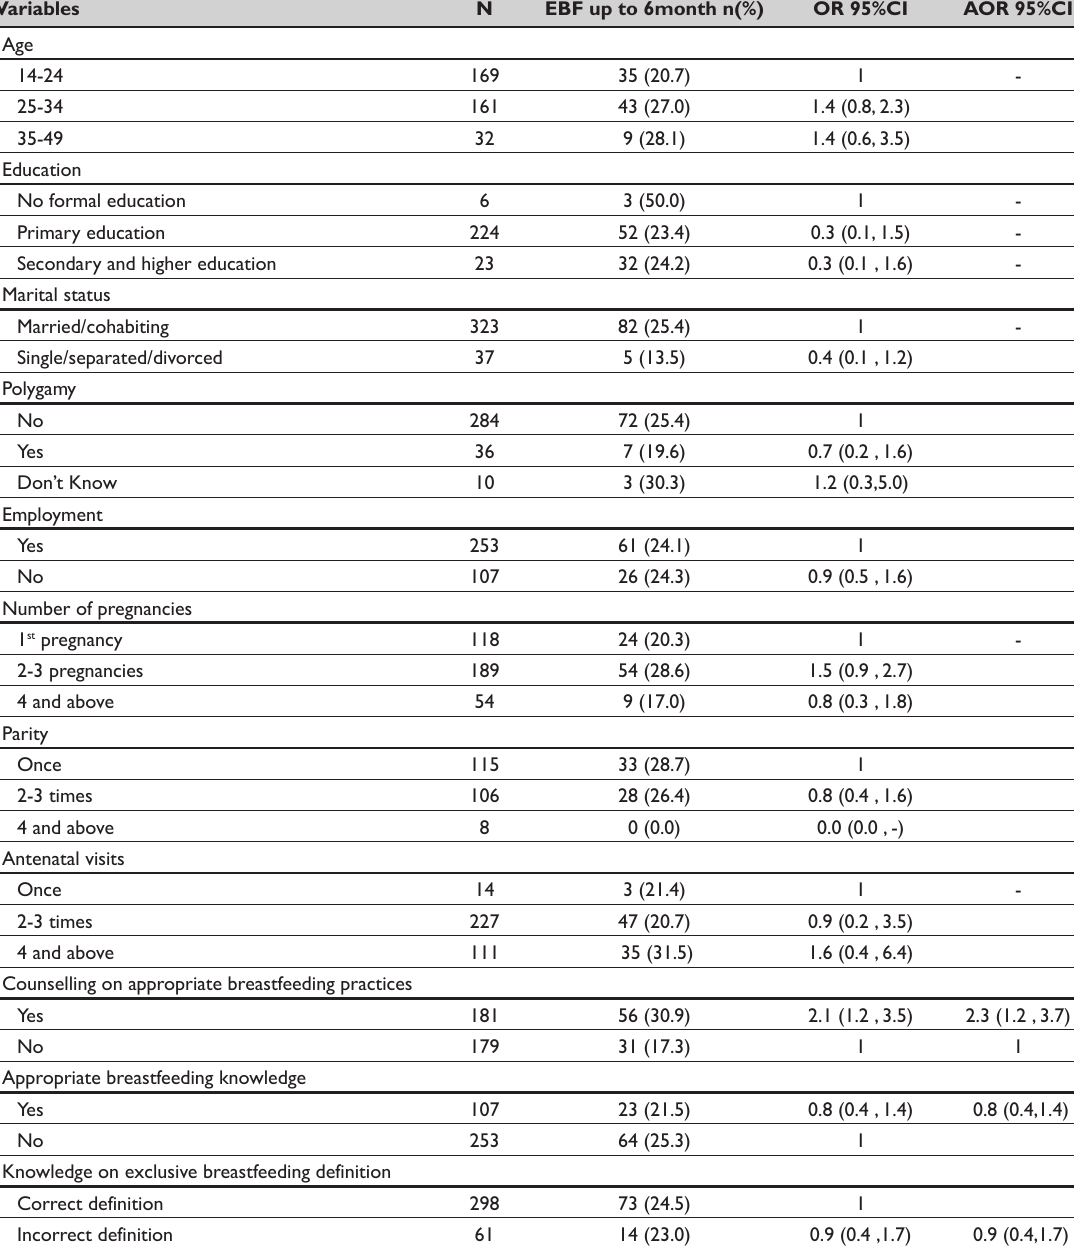
Table 4: Predictors of exclusive breastfeeding practices using recall since birth method among women with infants less than 1 year in Moshi urban,